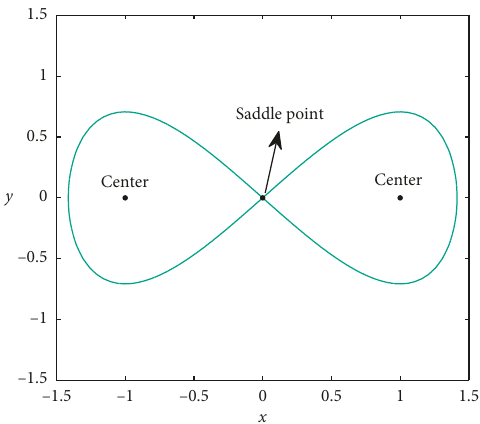
Figure 1: Homoclinic orbits of the system ( b